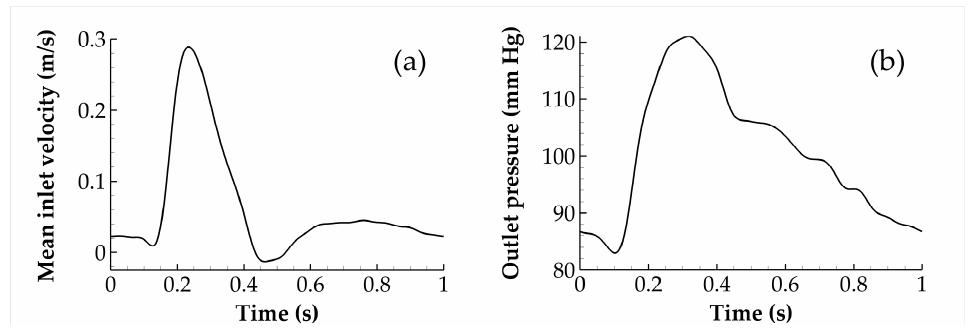
Figure 2. Mean inlet velocity ( a ) and outlet pressure ( b ) for all simulations considered in this study.